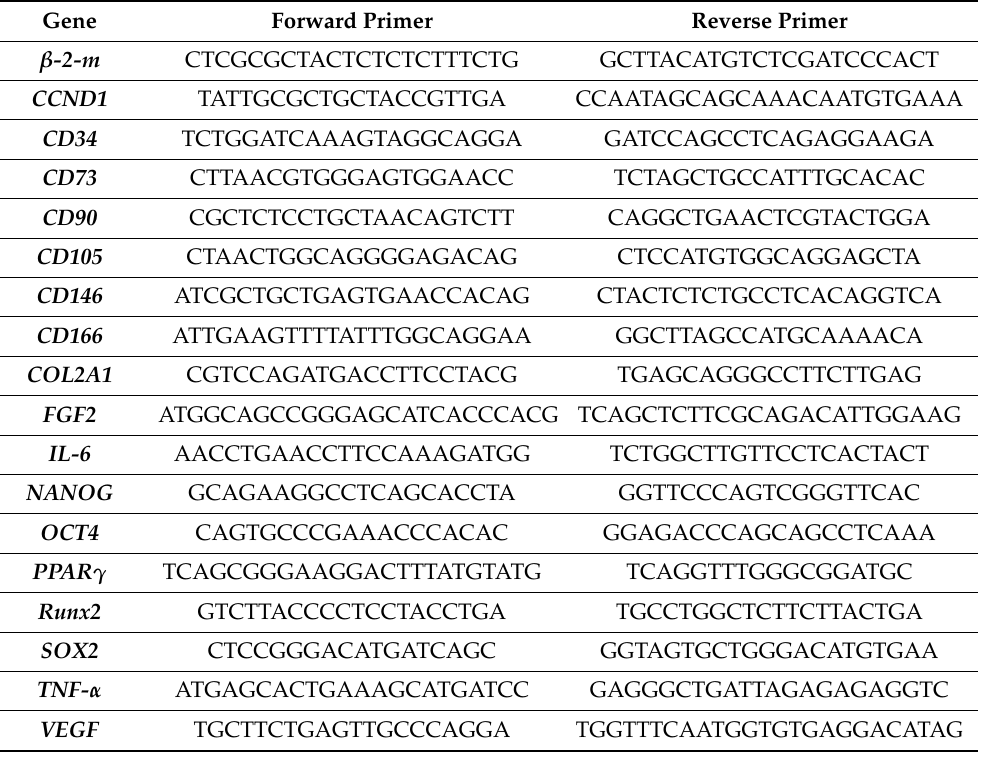
Table 1. Primer sequences used in quantitative real-time PCR